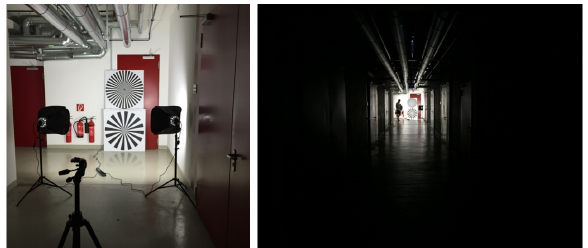
Table 2. Standard deviation of unfiltered point cloud from